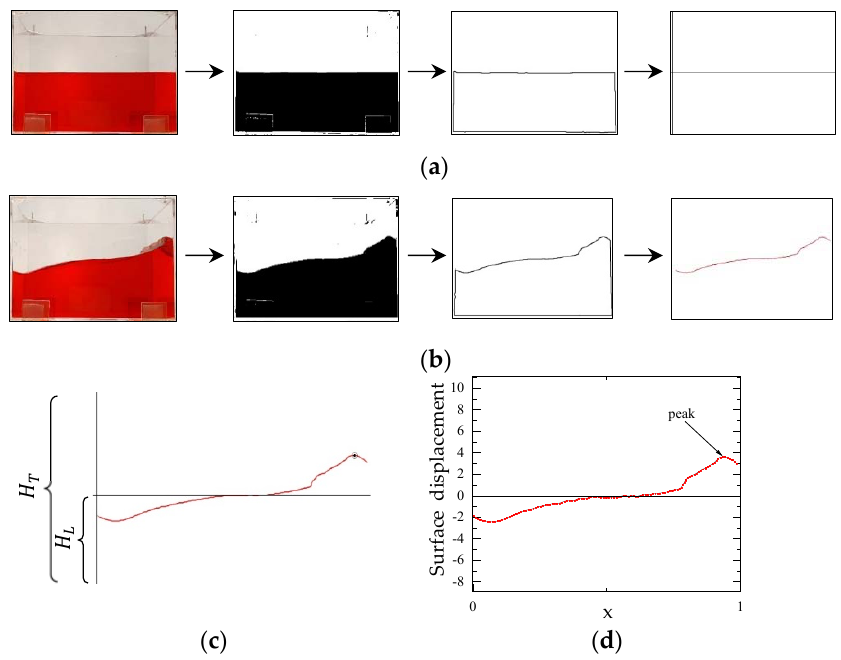
Figure 10. Image-extraction and peak-detection method: ( a ) stable liquid-level extraction, ( b ) highest Figure 10. Image ‐ extraction and peak ‐ detection method: ( a ) stable liquid ‐ level extraction, ( b ) high ‐ slosh-impact surface extraction, ( c ) extracted image merging, and ( d ) sloshing-surface graph-data est slosh ‐ impact surface extraction, ( c ) extracted image merging, and ( d ) sloshing ‐ surface graph ‐ data extraction.